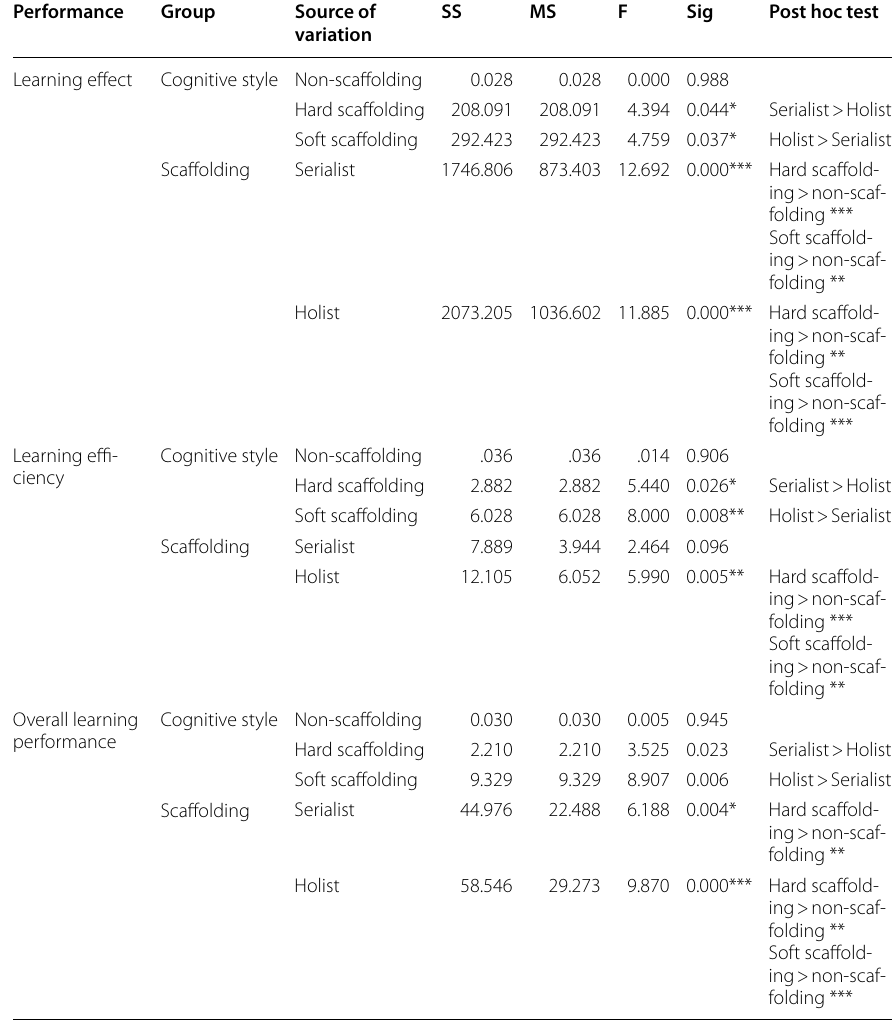
* p < 0.05, ** p < 0.01, *** p <